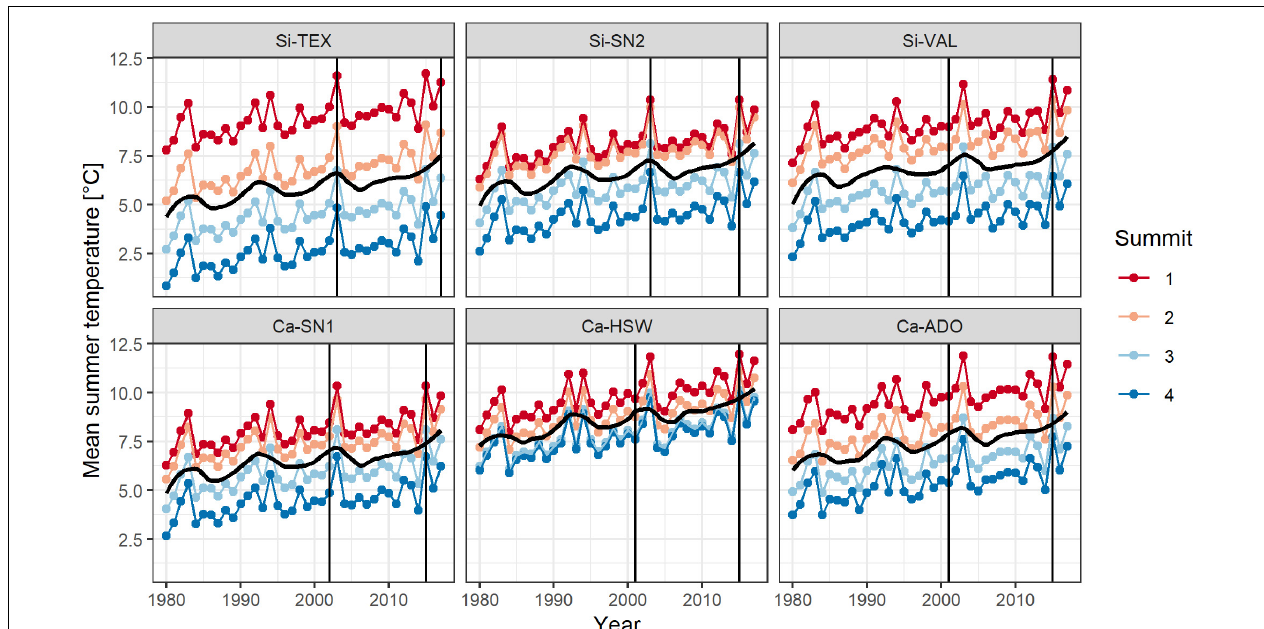
FIGURE 1 | Trend in mean summer temperatures on each four summits (1-4, in ascending order) in the six regions ( Table 1 ). Shown are averages of summer temperature (monthly means June, July, August) calculated with downscaled Chelsa satellite data (resolution 100 m) combined with CRU V4.03. Black trend lines represent a 10-year moving average. Vertical lines indicate the year of the first survey and the